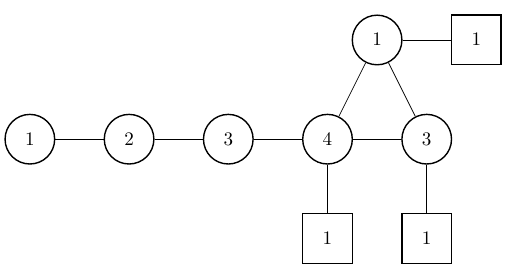
Figure 20 . The 3d mirror of the theories T and T ∨ in figure